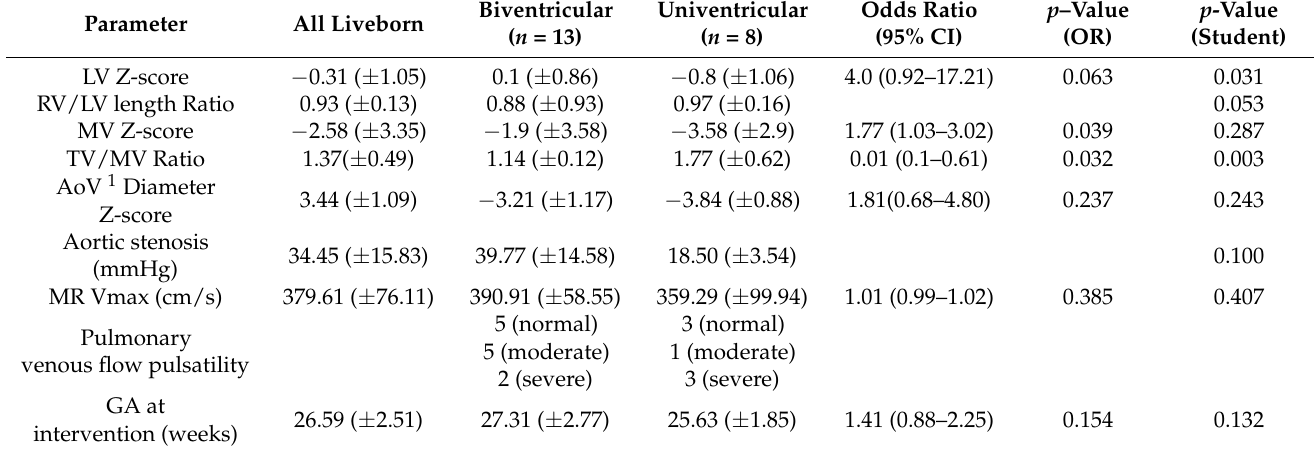
Table 2. Preinterventional echocardiographic characteristics and univariate analysis of fac- tors for biventricular circulation outcome of live born fetuses with CAS prior to fetal aortic valvuloplasty